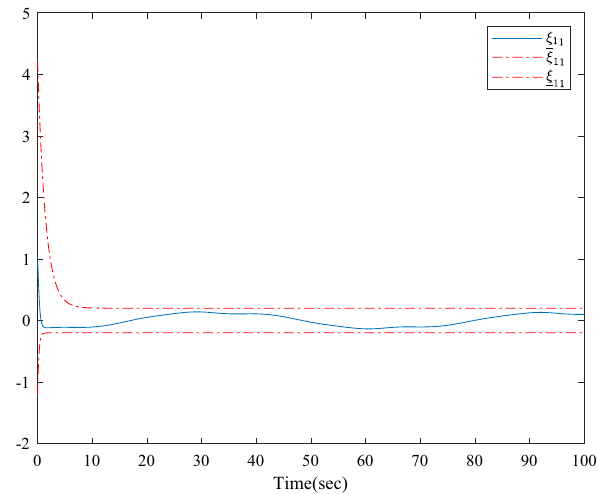
Figure 5. Error states of the following agents ξ 11 along with their bounds.